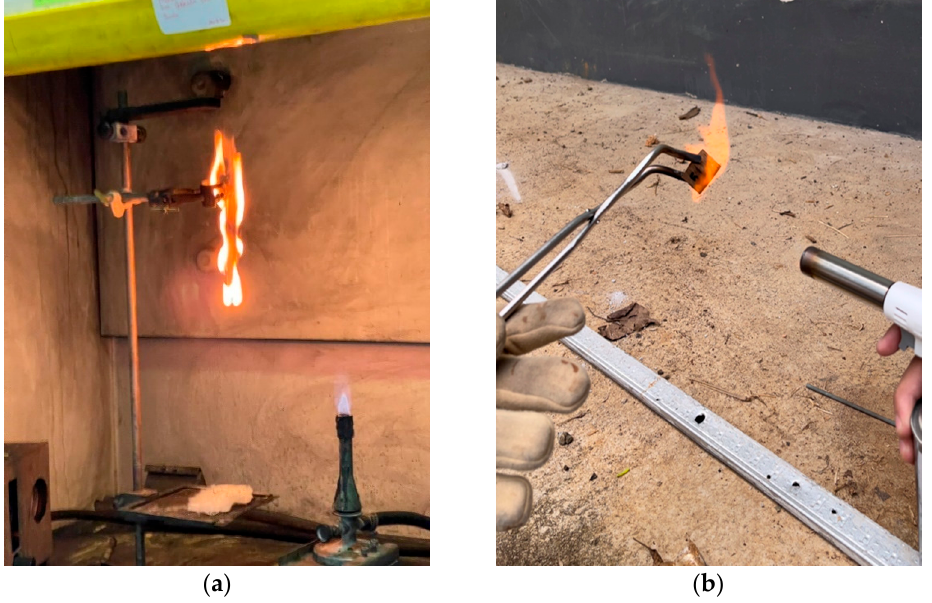
Figure 3. Flammability testing by UL-94 in vertical burning test ( a ) and gas torch ( b ).